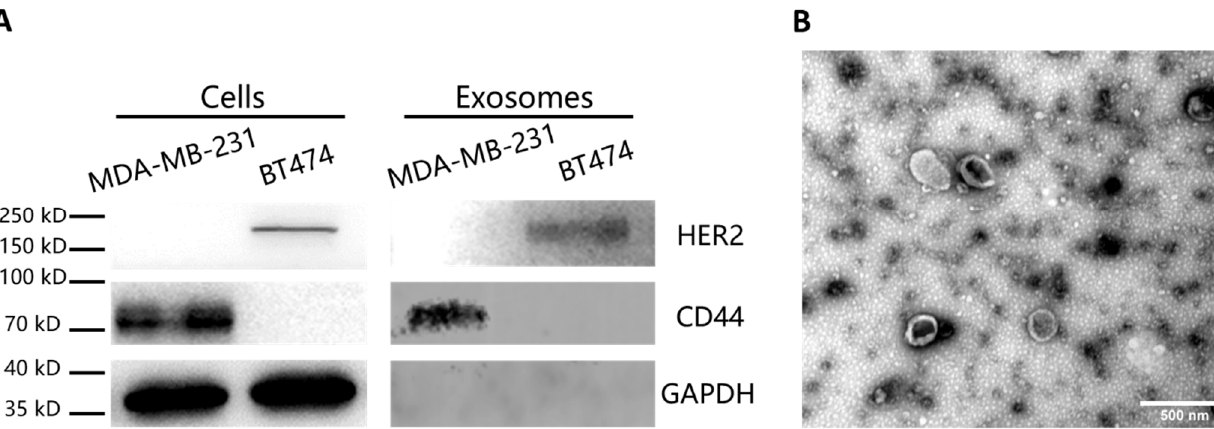
Figure 2. Characterization of the EV samples. ( A ) Western blot with expression of MDA-MB-231 marker (CD44), BT474 marker (HER2) and loading control (GAPDH) in cells and EVs. ( B ) TEM image of the EVs collected by ultracentrifugation.